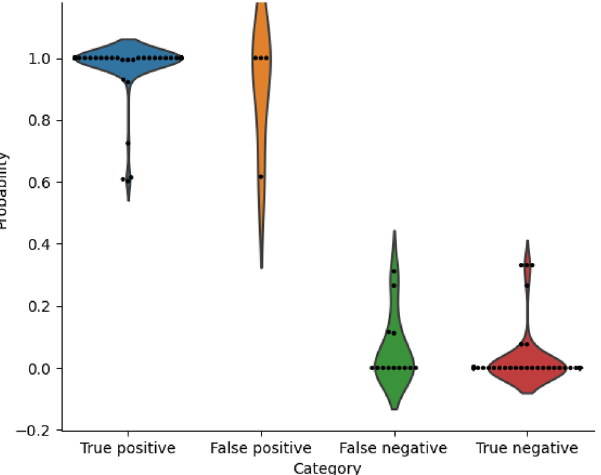
Figure 5. Violin plot for the probability of ARIA output in differentiating artefact-associated-poor-quality from eye-abnormality-associated-poor-quality in the external validation dataset (predicted value of probability: 0: Artefact-associated-poor-quality; 1: